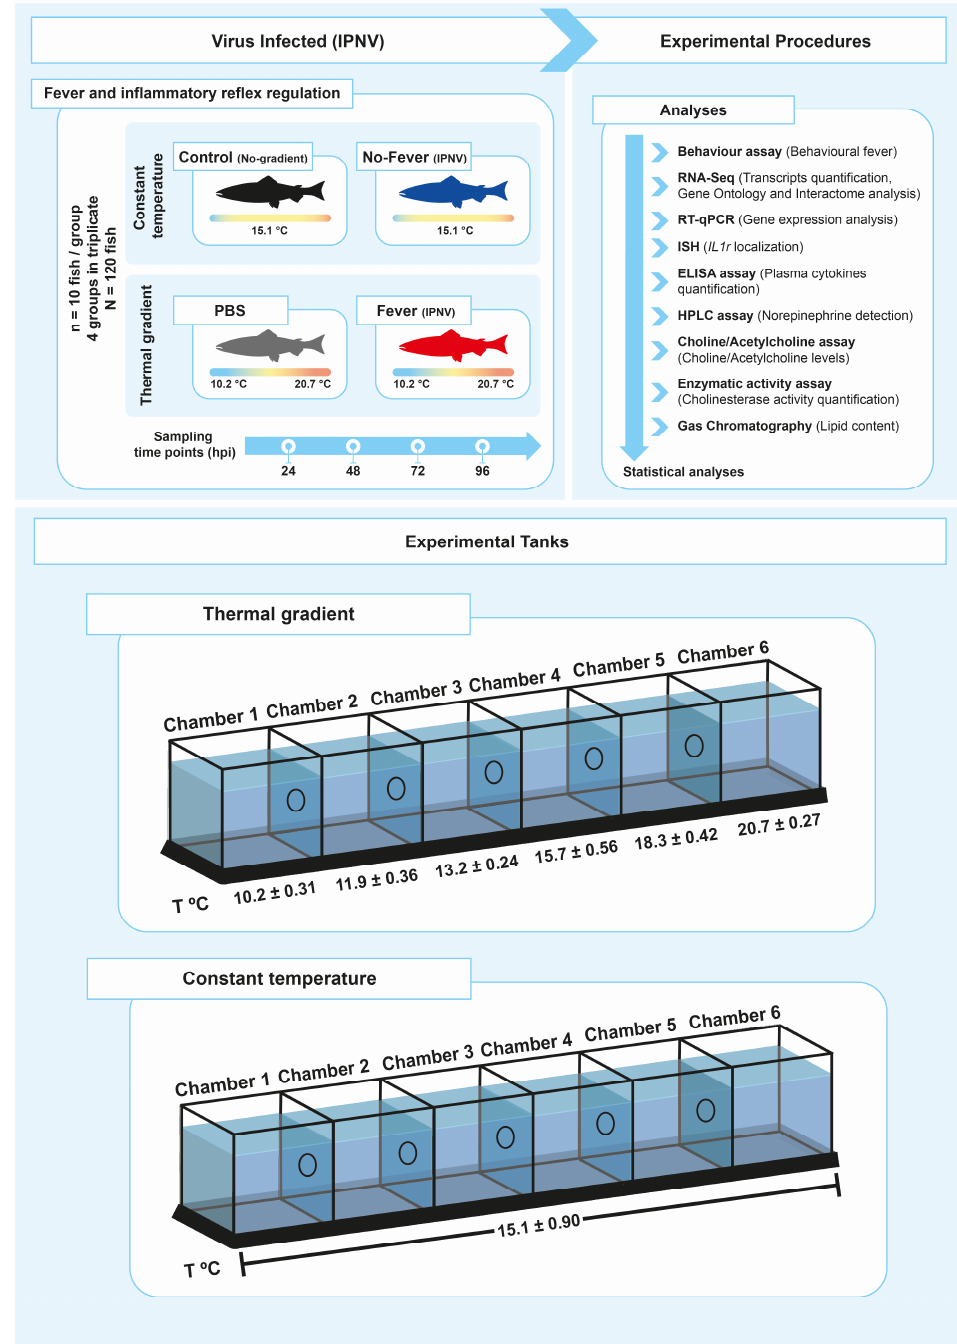
Figure 1. Experimental setup. Schematic representing the experimental design of thermal treatments after viral challenge. A summary of all analyses performed to study the neuro-immune interaction in the control of inflammation during behaviour fever in fish is presented ( A ). The experimental tanks set-up and the temperature associated with each chamber are also shown ( B ). The mean temperature ± SD value for each chamber is indicated. IPNV: infectious pancreatic necrosis virus; hpi: hours post-infection; SD: standard deviation.